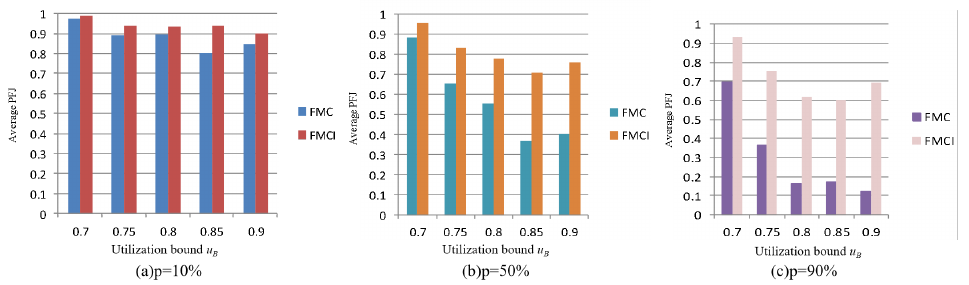
Figure 6. Comparison of scheduling results under different probabilities of overruns in high-criticality